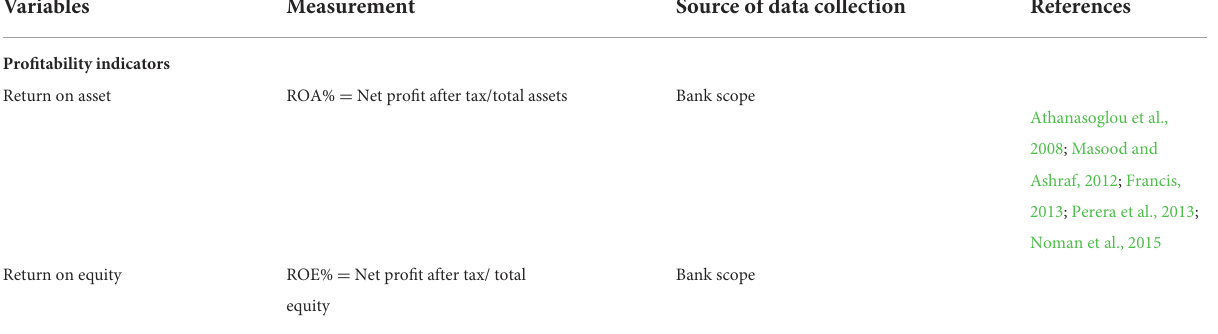
TABLE 2 Description of independent